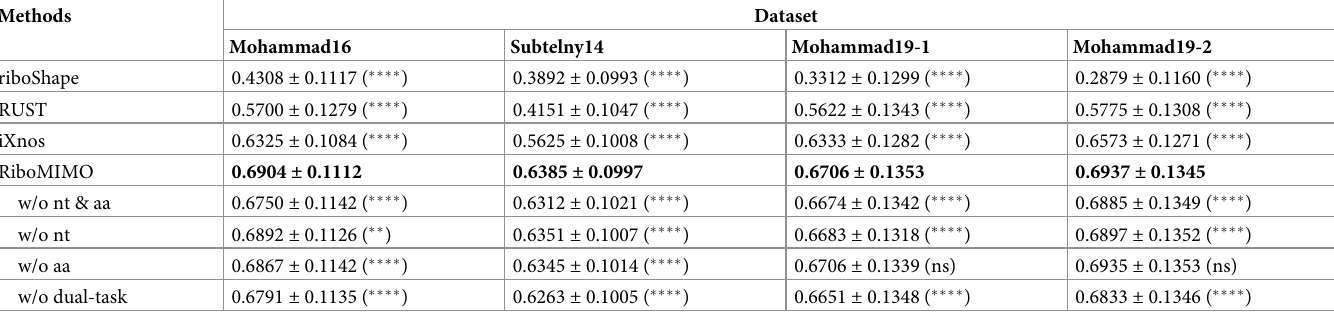
Table 1. Performance evaluation of different prediction methods, measured in terms of the Pearson’s correlation coefficient. Methods Dataset